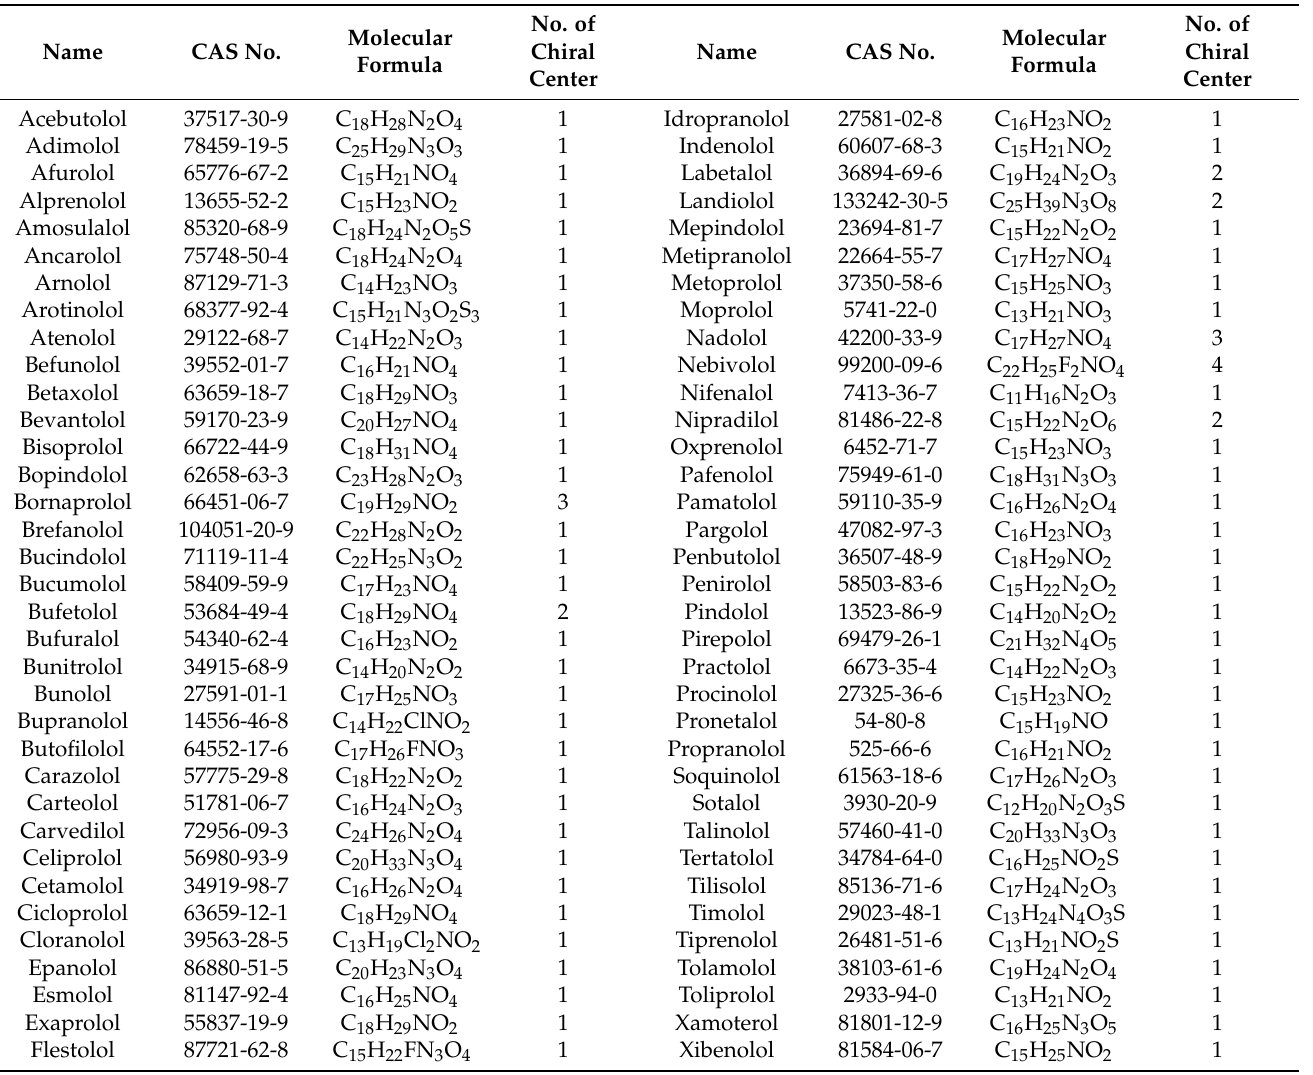
Table 2. List of β -blockers reported in the